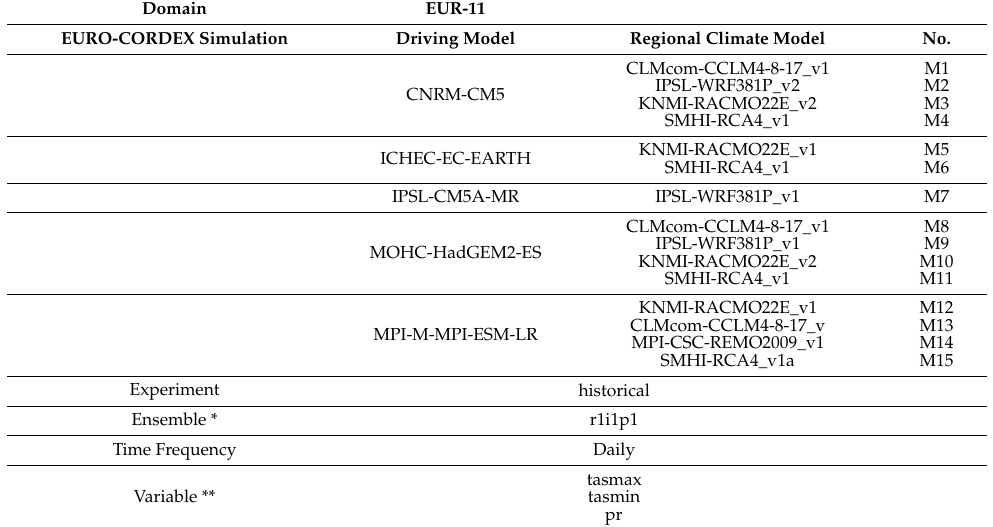
Table 1. Modeled data